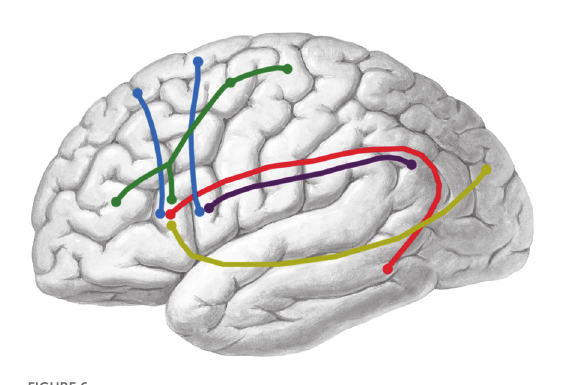
FIGURE6 Schematic summary of the bundles connecting Broca’s area. The shape of the colored lines represents the rough anatomical path of each fiber tract. Color identifies different tracts. IFOF, yellow; AF, red; SLF-III, purple; FAT, blue; FLF, green.